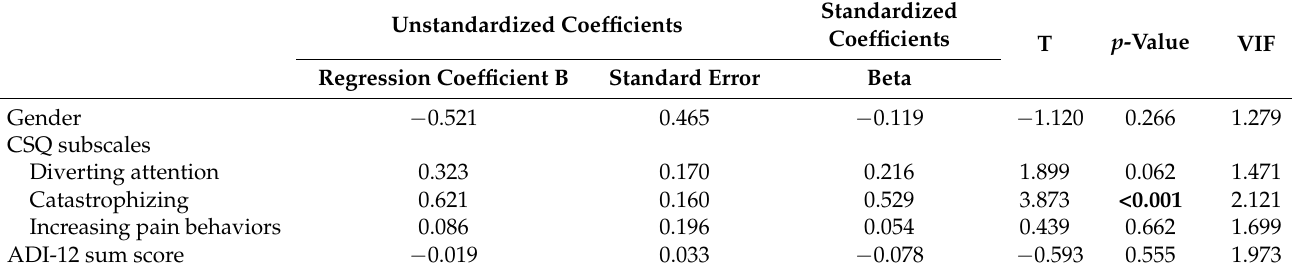
Table 3. Multiple regression analysis of potential predictors of the average pain intensity ratings according to the Brief Pain Inventory (dependent variable).